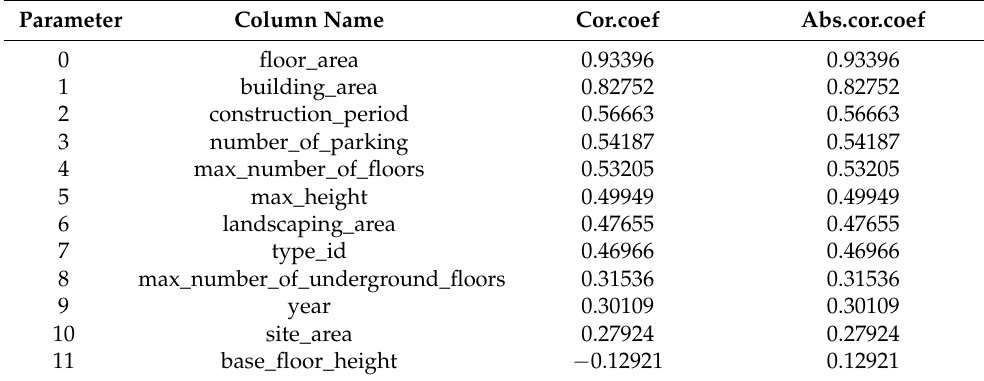
Table 4. Correlation coefficient for each factor.